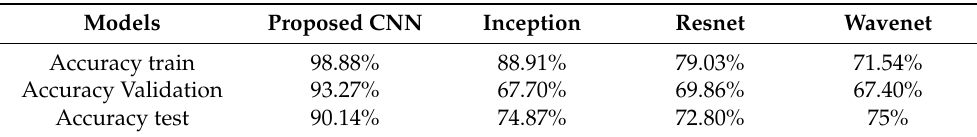
Accuracy comparison of the proposed CNN model with ResNet, Inception and WaveNet models.